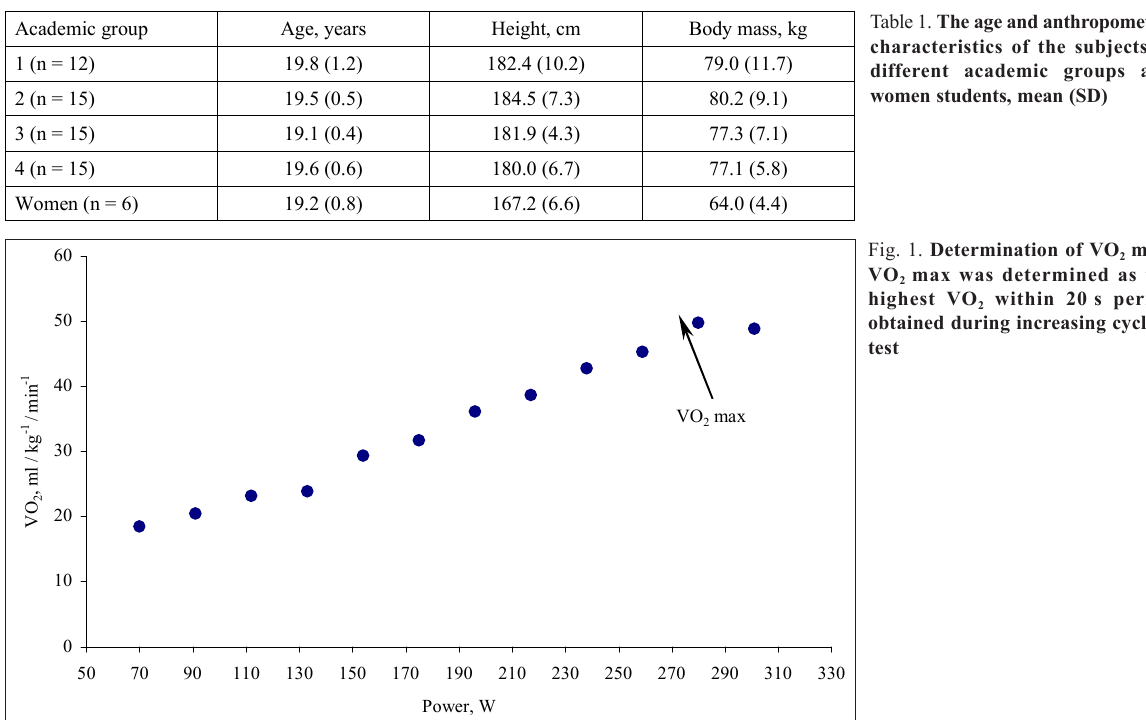
Fig. 1. Determination of VO